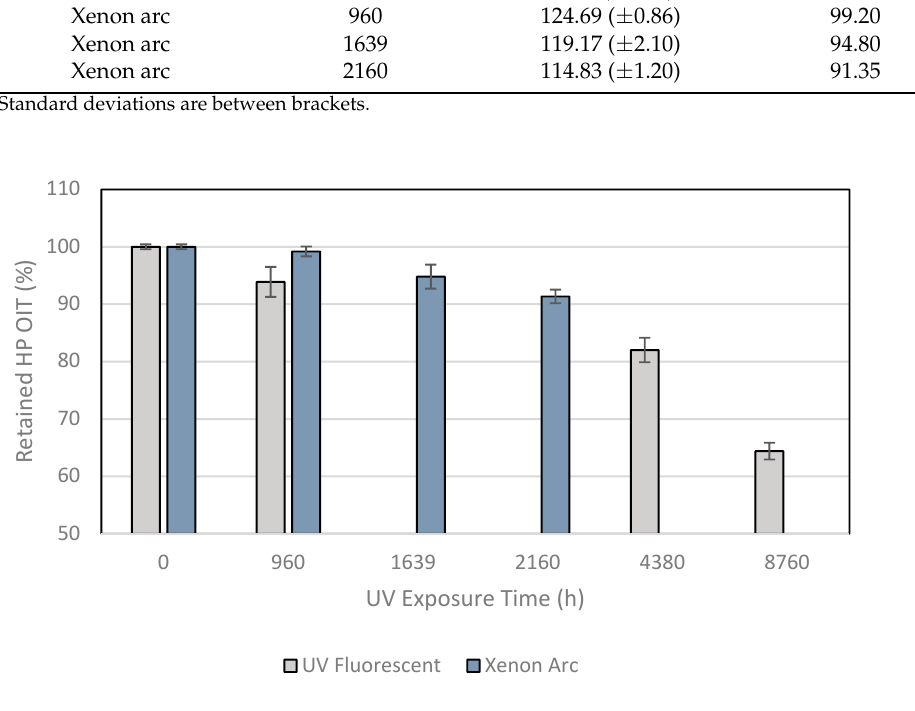
Figure 4. HP OIT test results showing behavior of the samples after UV exposures.